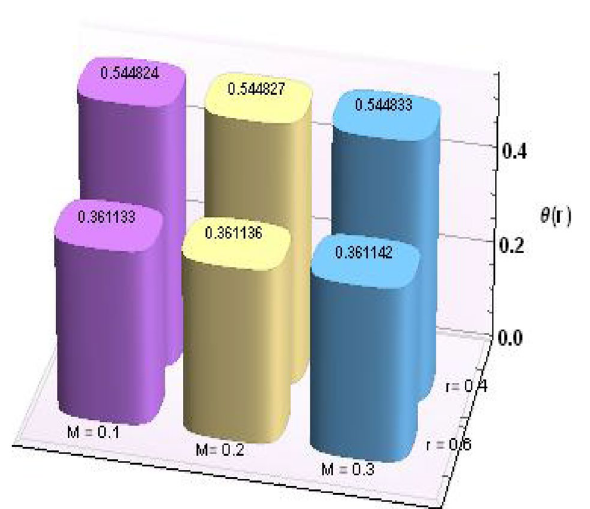
Figure 14. Variation in θ(r) against Ec .